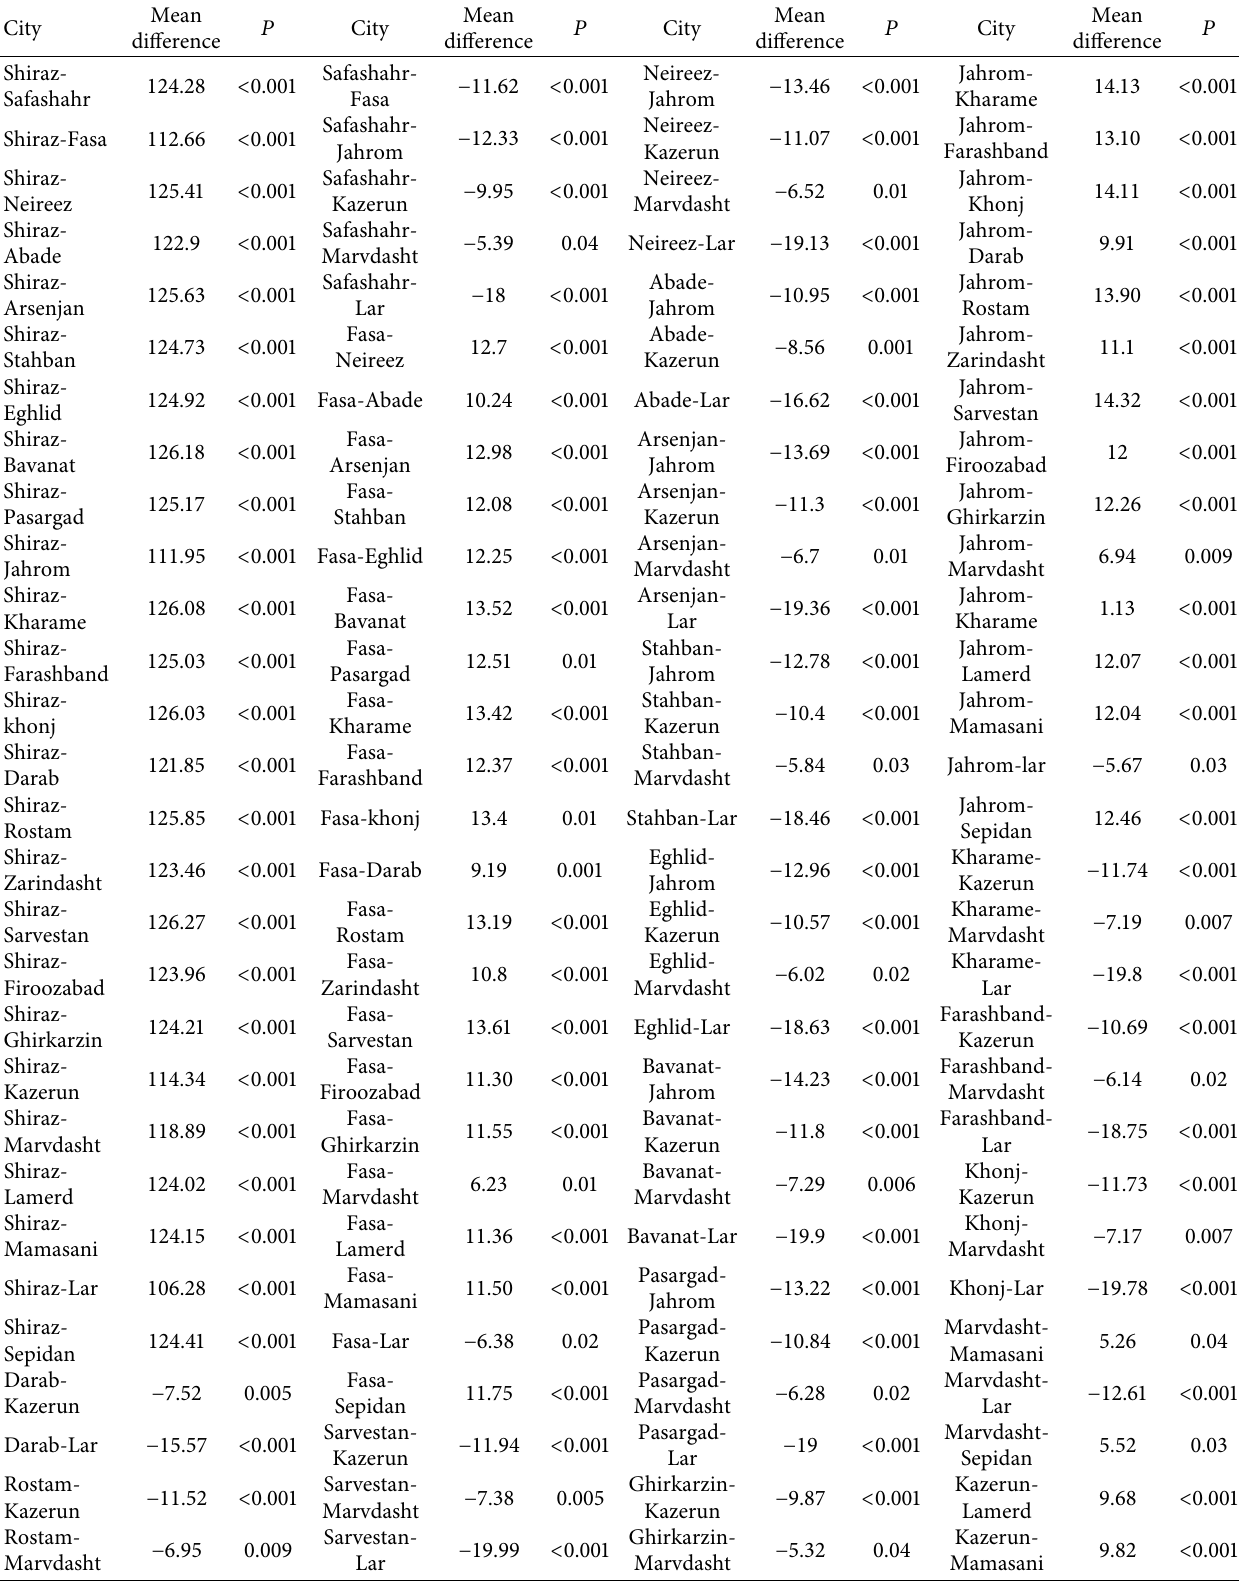
Table 3: Pairwise comparisons of 53 554 COVID-19 cases across 26 cities of Fars province, Iran, during February 18–September 30, 2020.